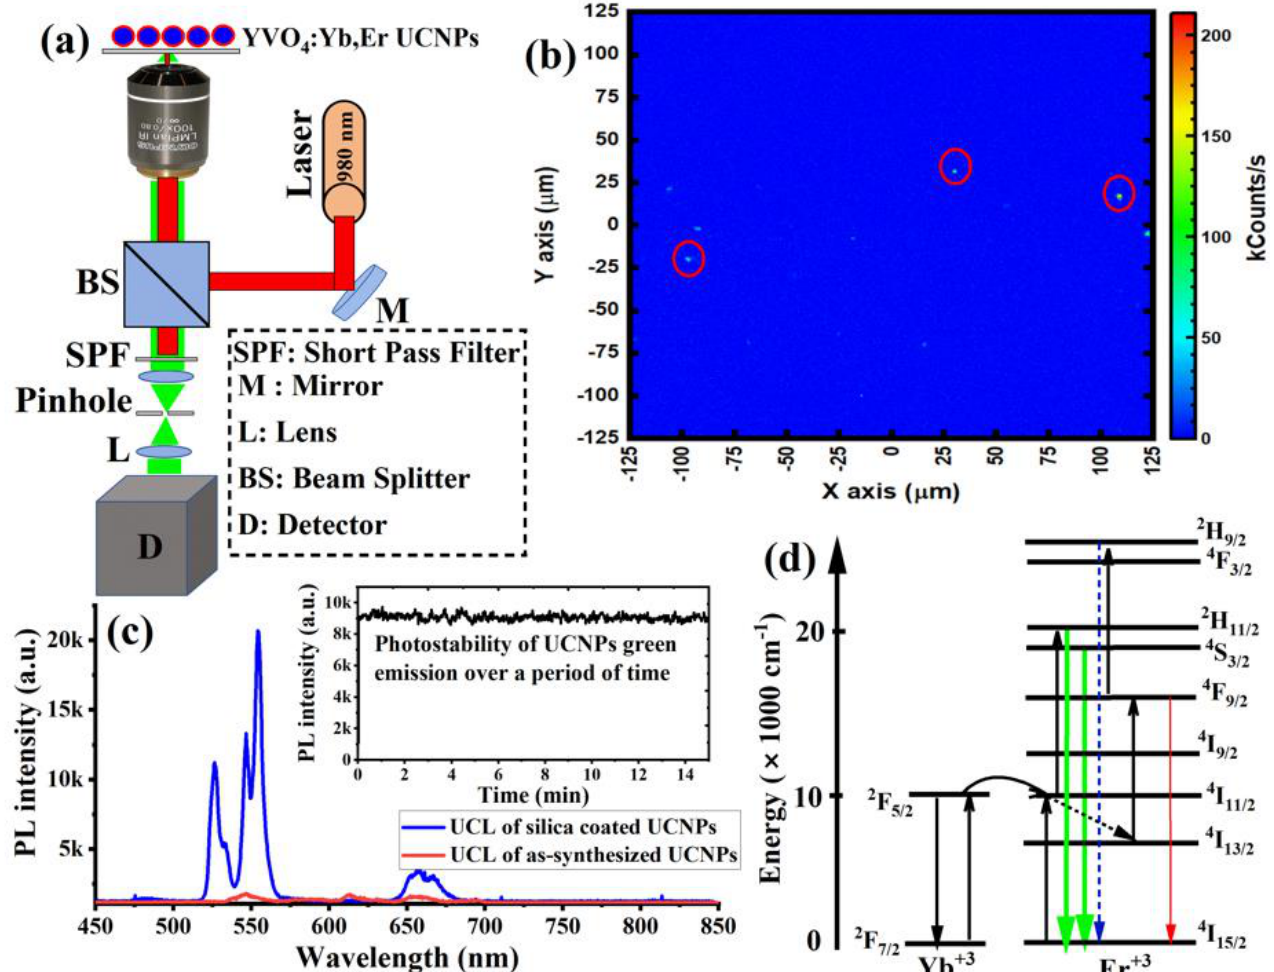
Figure 3. ( a ) An illustration of optical setup used for optical characterizations in this study. The optical setup consists of 980 nm excitation laser, custom-built confocal microscope, and spectrometer. ( b ) Optical scan of the spin-coated UCNPs under 980 nm laser illumination. ( c ) Upconversion luminescence (UCL) spectrum of the synthesized UCNPs before and after high-temperature treatment. UCL of synthesized UCNPs showed a very weak spectrum due to overall poor crystallinity. The fluorescence of the UCNPs after high-temperature treatment showed two strong green emissions at 525 nm and 550 nm, and a weak emission at 650 nm. ( d ) Electronic structure and upconversion energy transfer processes between energy synthesizer (Yb +3 ) and activator ion (Er +3 ) under 980 nm laser excitation (photon upconversion) .